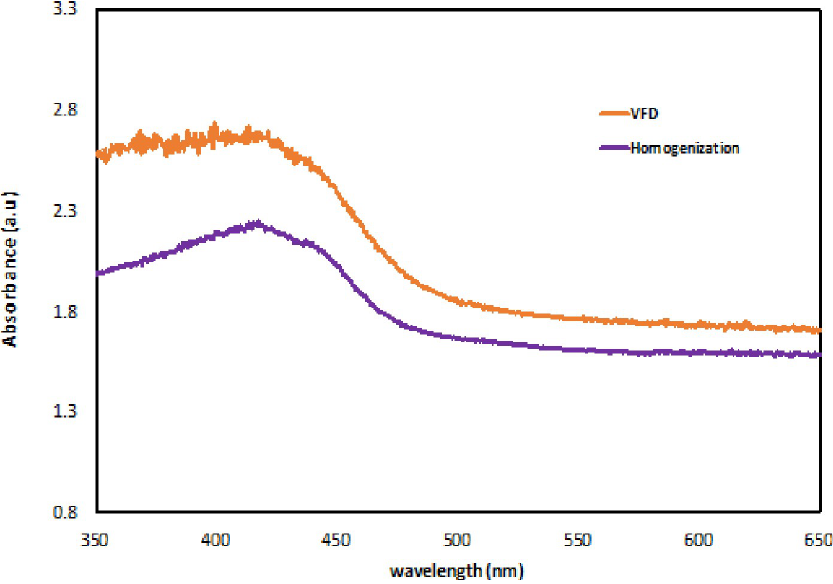
Fig 7. UV-visible spectroscopy (temperature: 25˚C; path-length of quartz cuvette: 10 mm) for VFD and homogenization samples.